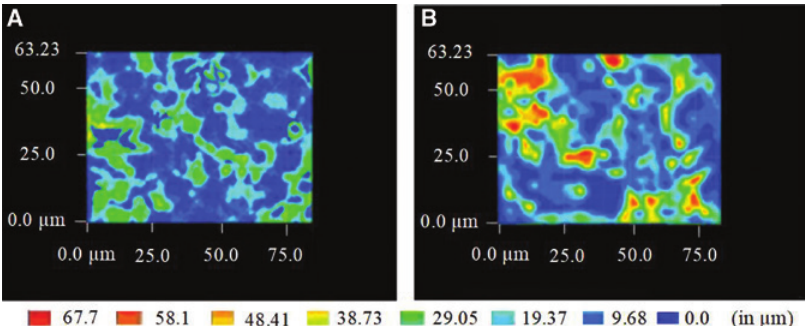
Figure 3: 3-D optical images of (A) pure epoxy surface, (B) epoxy-CNTs-raw composite surface from digital microscope (Keyence; scale bar: red 67.7, yellow 38.7, green 29.06, and dark blue 0.0 l m).